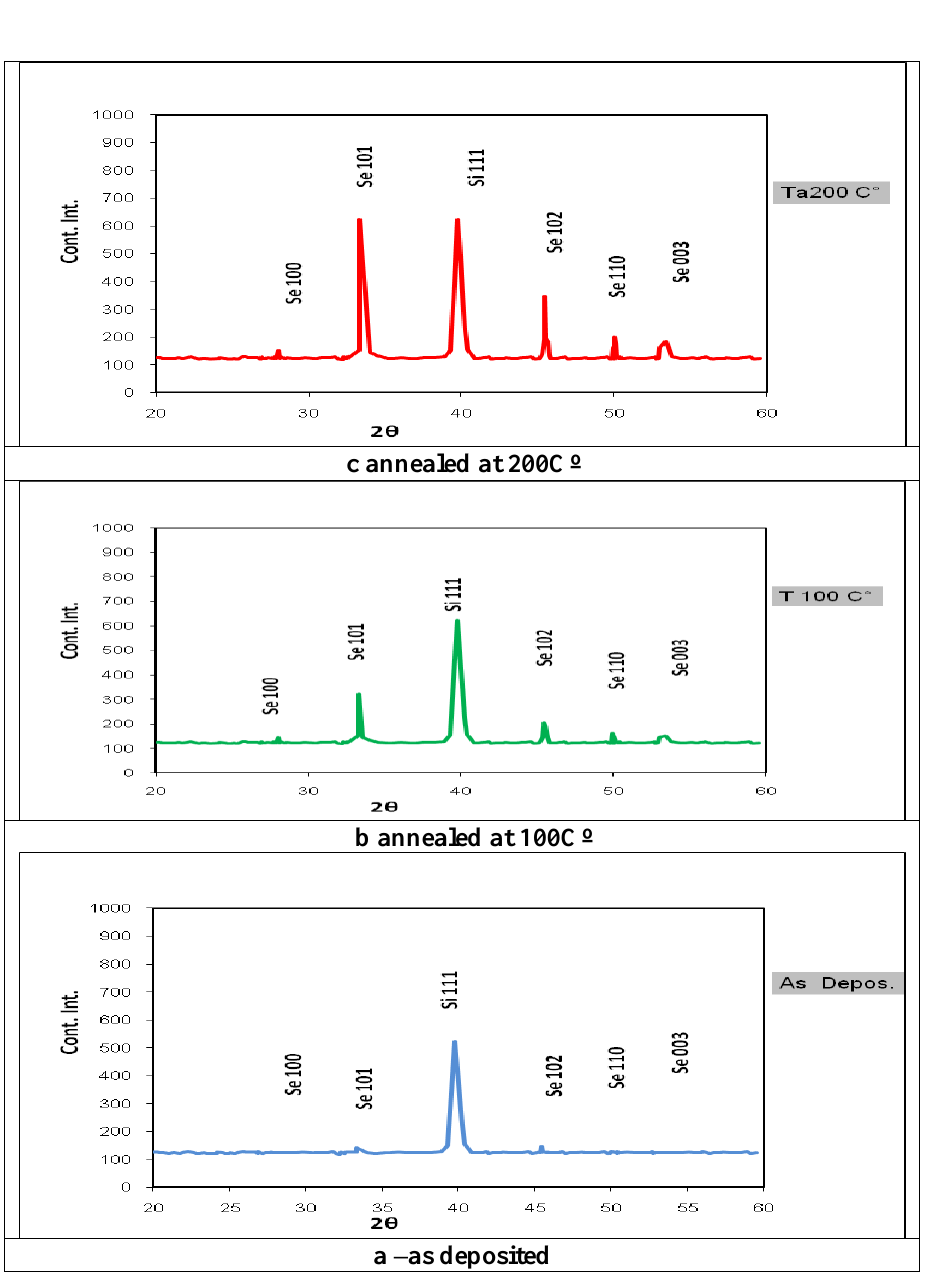
Fig. 3: XRD of selenium thin film at different annealing